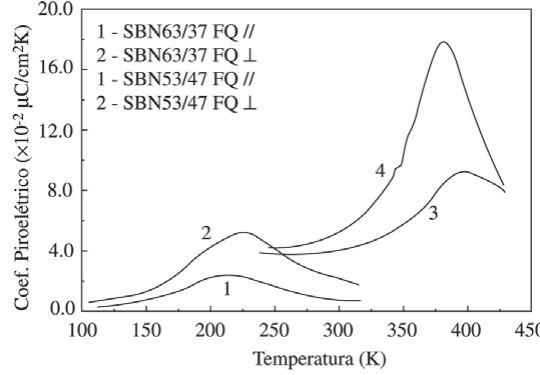
Figura 8. Coeficiente piroelétrico como função da temperatura em cerâmicas ferroelétricas de SBN, forjadas a